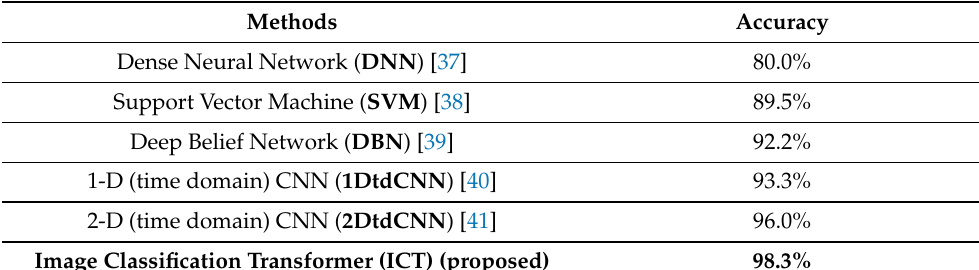
Table 6. Comparison results with other machine learning competitive